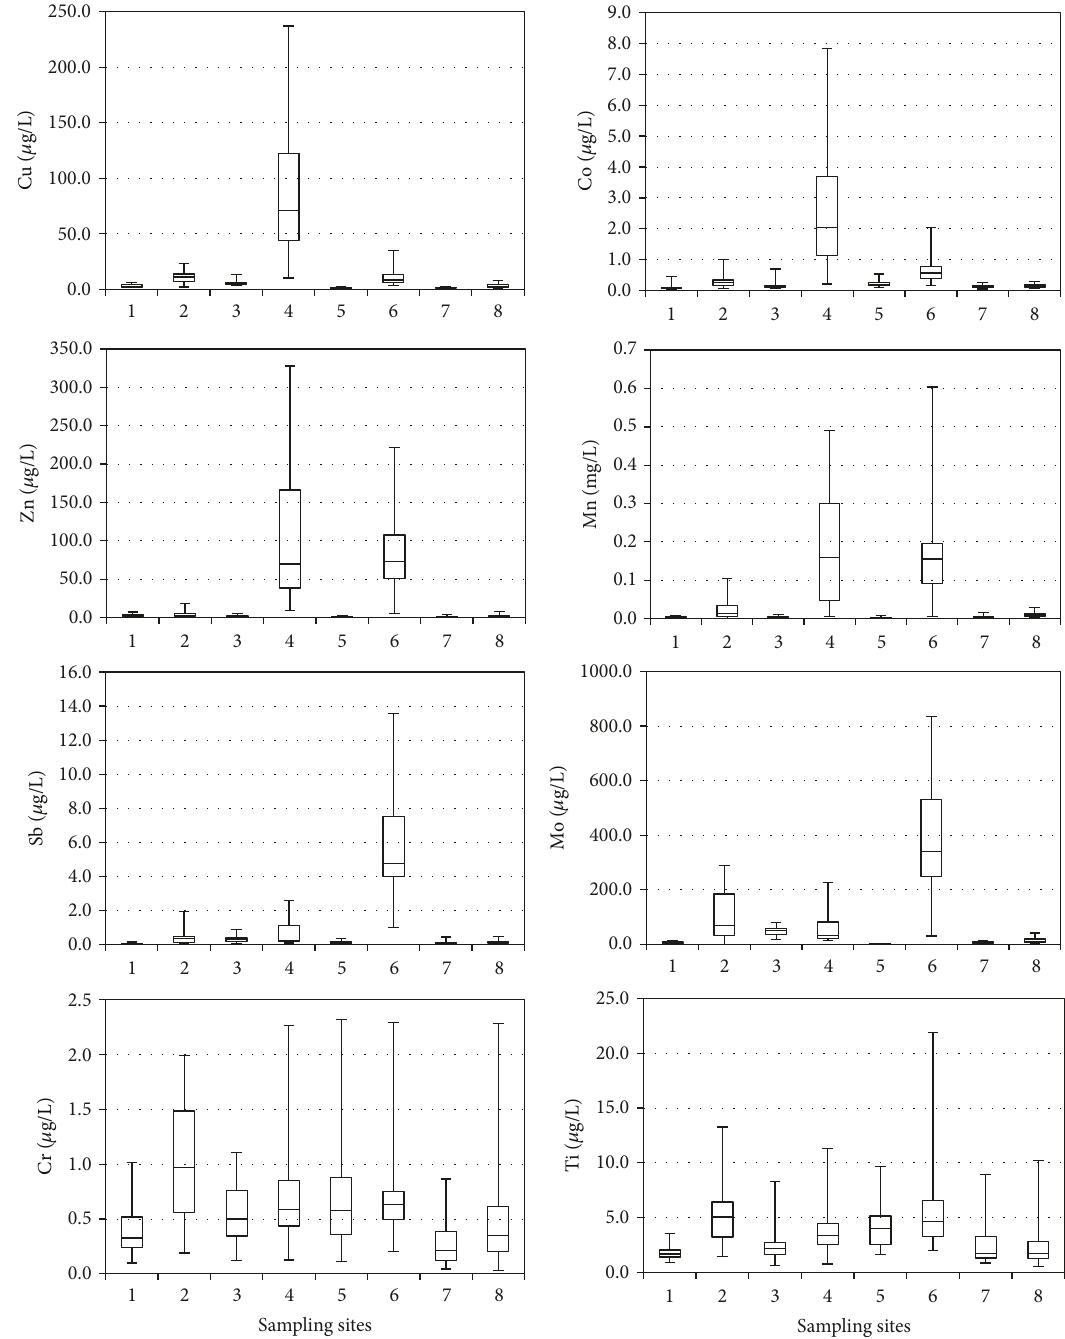
Figure 2: Spatial distribution of concentrations values of some heavy metals in the waters of Voghji River and its tributaries. Median, 25th and 75th percentiles are shown in the box; whiskers indicate the maximums and